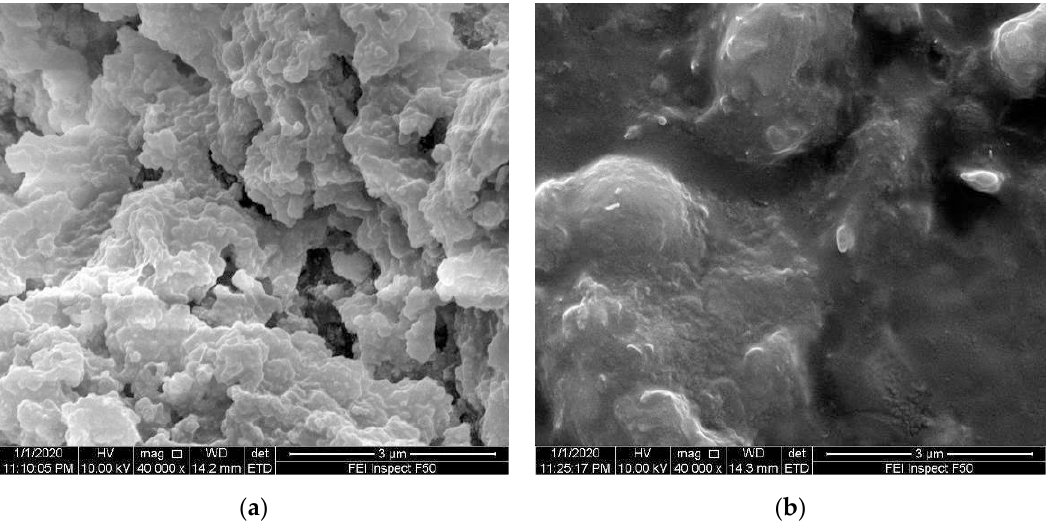
Figure 5. SEM imaging: ( a ) TAP and ( b ) TAPMA with 15% TAP content.